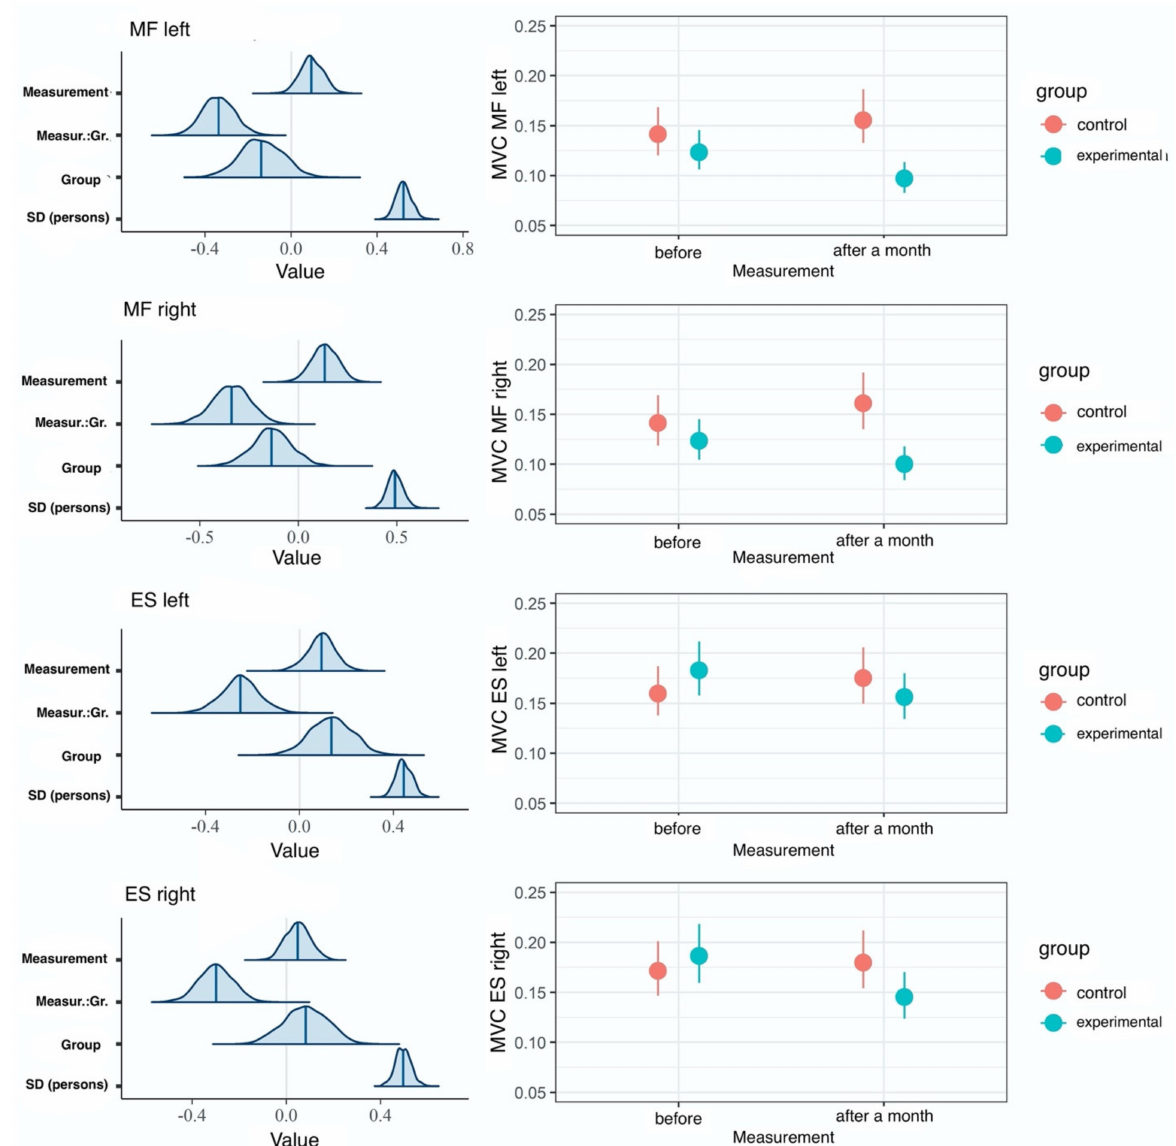
Figure 6. Results of hierarchical four-dimensional lognormal regression analysis with MVC as the dependent variable, and the measurement and the group as predictors. Left panels: a posteriori distributions of regression coefficients. The shaded areas represent 95% confidence areas. Right panels: estimated marginal means. The points represent means of a posteriori distributions, whereas vertical lines indicate 95% confidence